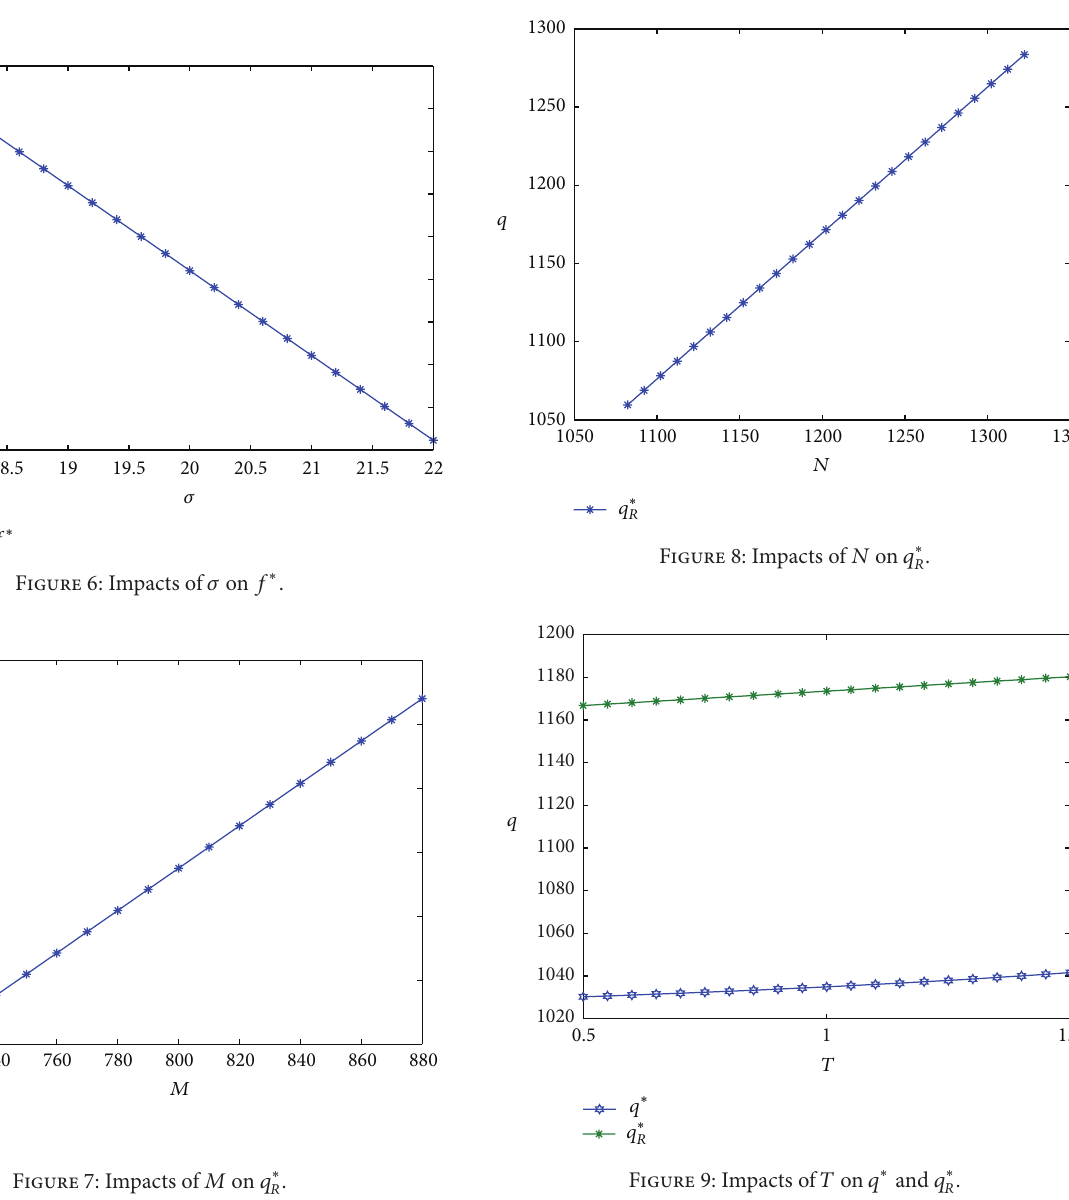
Figure 7: Impacts of 𝑀 on 𝑞 ∗ 𝑅 .